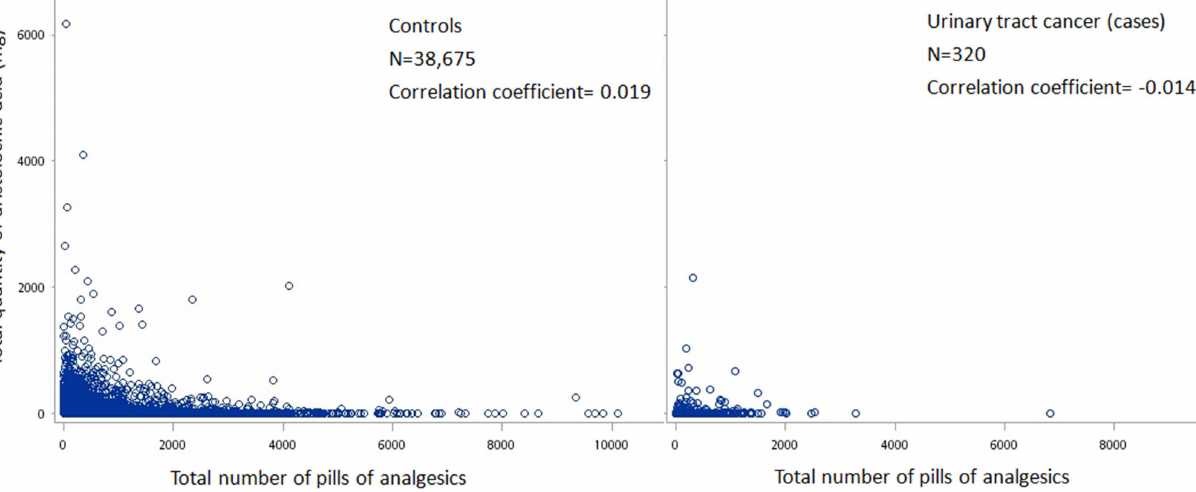
Figure 1. Correlation analysis between prescription of analgesics (number of pills) and cumulative dose of aristolochic acid for both cases and controls. doi:10.1371/journal.pone.0105218.g001 PLOS ONE |